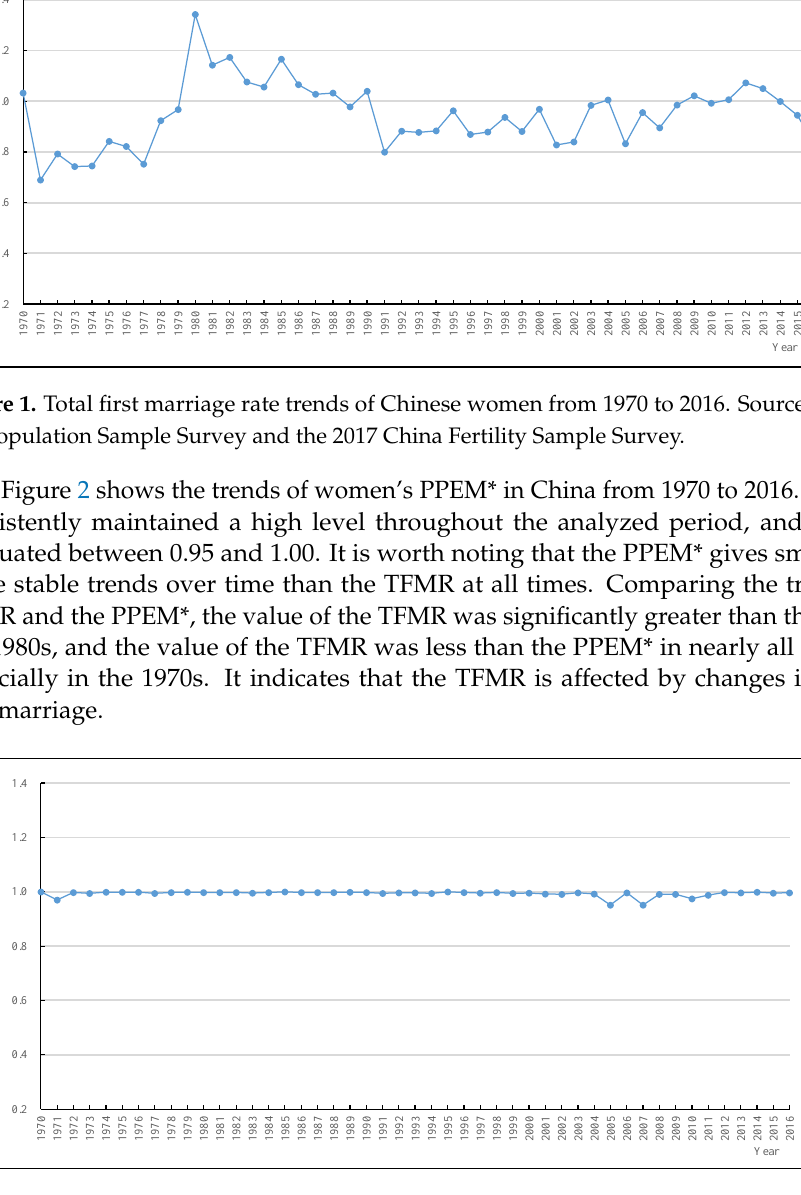
Figure 2. Tempo-adjusted period proportion ever married trends of Chinese women from 1970 to 2016. Source: 2005 China 1% Population Sample Survey and the 2017 China Fertility Sample Survey.